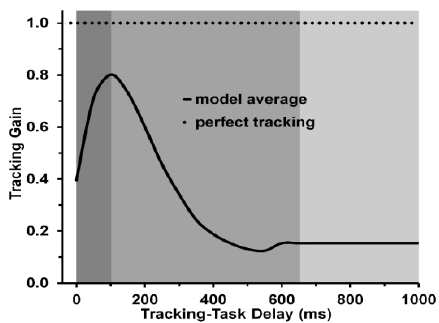
Figure 7. Tracking gain in a visually guided tracking task (moving a cursor on a display monitor